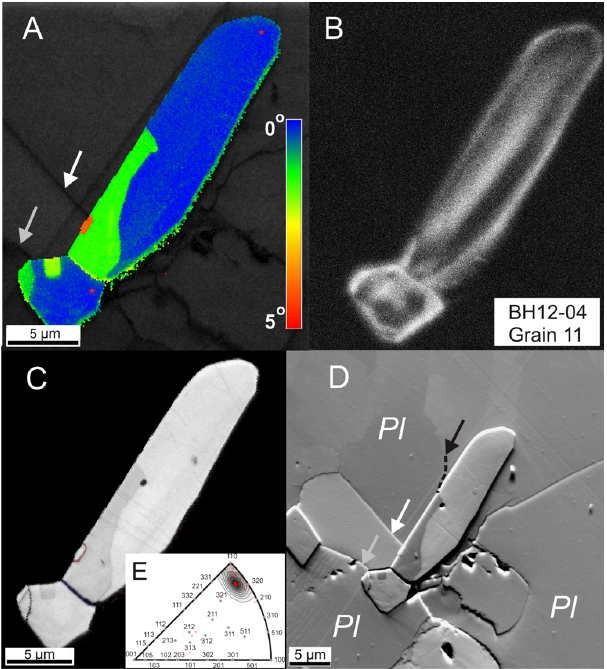
Figure 7. Grain BH12-04_11, lattice distortion type (III) case 4. (a) EBSD map color-coded for zircon misorientation with respect to a reference point (red star marker). Arrows mark plagioclase grain boundary segments. (b) CL image. (c) EBSD pattern quality map with subgrain boundaries colored for misorientation angles between subgrains (red line = 2–5 ◦ ). (d) FSE image; black arrow and dashed line mark plagioclase subgrain boundary; white and grey arrows as in (a) ; Pl: plagioclase. (e) Inverse pole figure plot of the misori- entation axes distribution density showing maxima close to zircon